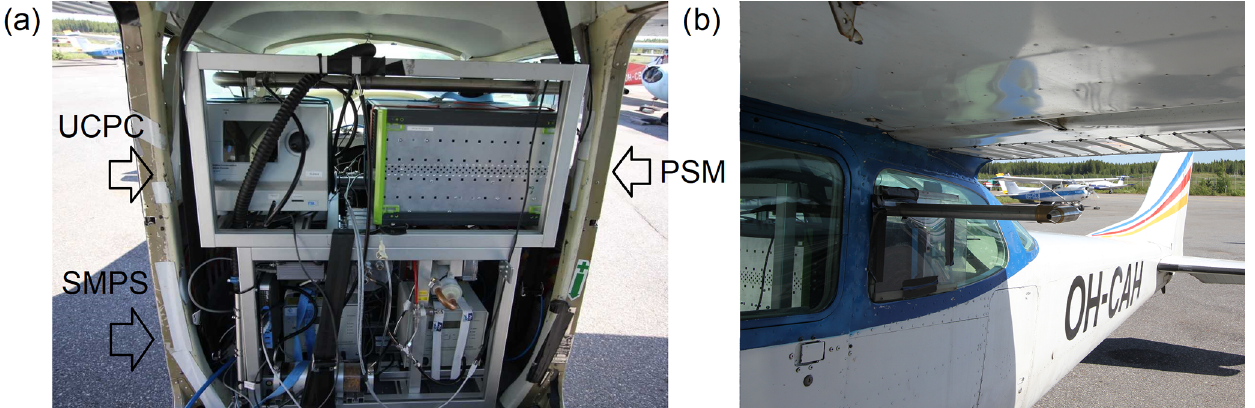
Figure 1. The instrumentation rack was installed inside the cabin (a) and the sample air for the instrumentation was taken from a steel tube at a 50cm distance from the fuselage of the plane (b) . The main instruments (ultrafine CPC, PSM and SMPS) are shown in the